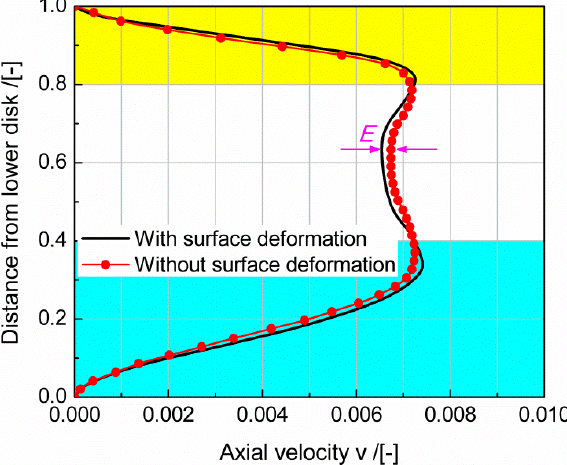
Figure 3. Distribution of axial velocity on free surface (∆ C = 0.015, Ca C = −0.006, H/R = 1.0, Vr = 1.0).